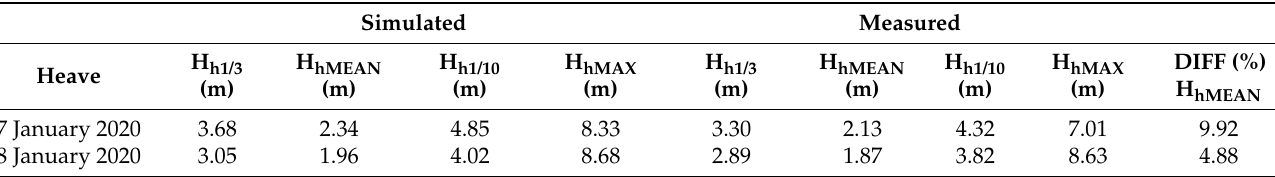
Figure 10. Acceleration time series comparison: ( a ) 7 January 2020; ( b ) 8 January 2020. Table 4. Results comparison for heave motion.